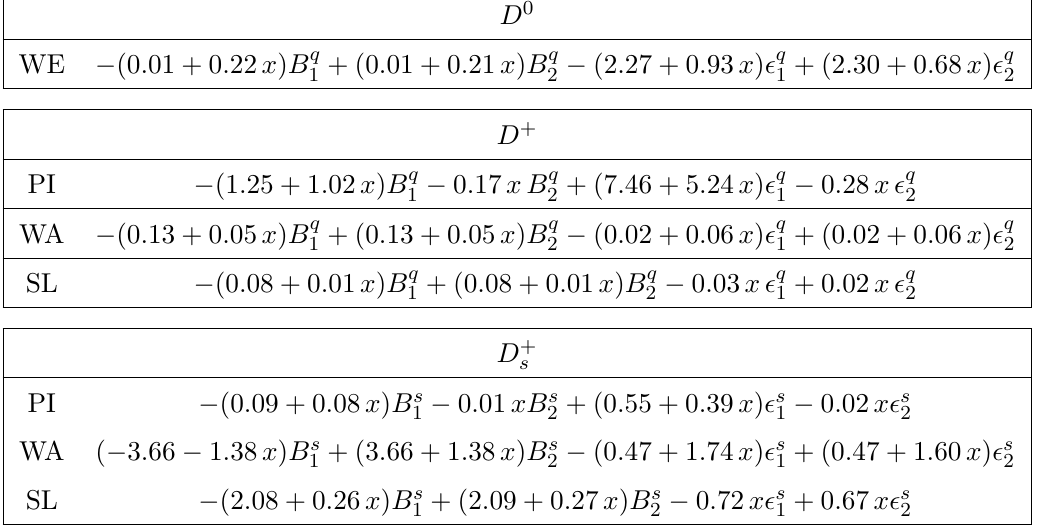
Table 12. Contributions of valence dimension-six spectator operators to the decay widths of charmed mesons, in units ps − 1 , in the MS scheme. The different contributions are separated by the topologies defined in figure 2. The HQET bag parameters have been left unevaluated, but are assumed to be renormalized at the scale µ 1 . 5 GeV. Their coefficients correspond to the scale 0 ∼ µ = 1 . 5 GeV. The factor x = 1 denotes the O ( α s ) contributions. Semileptonic contributions involve both e and µ